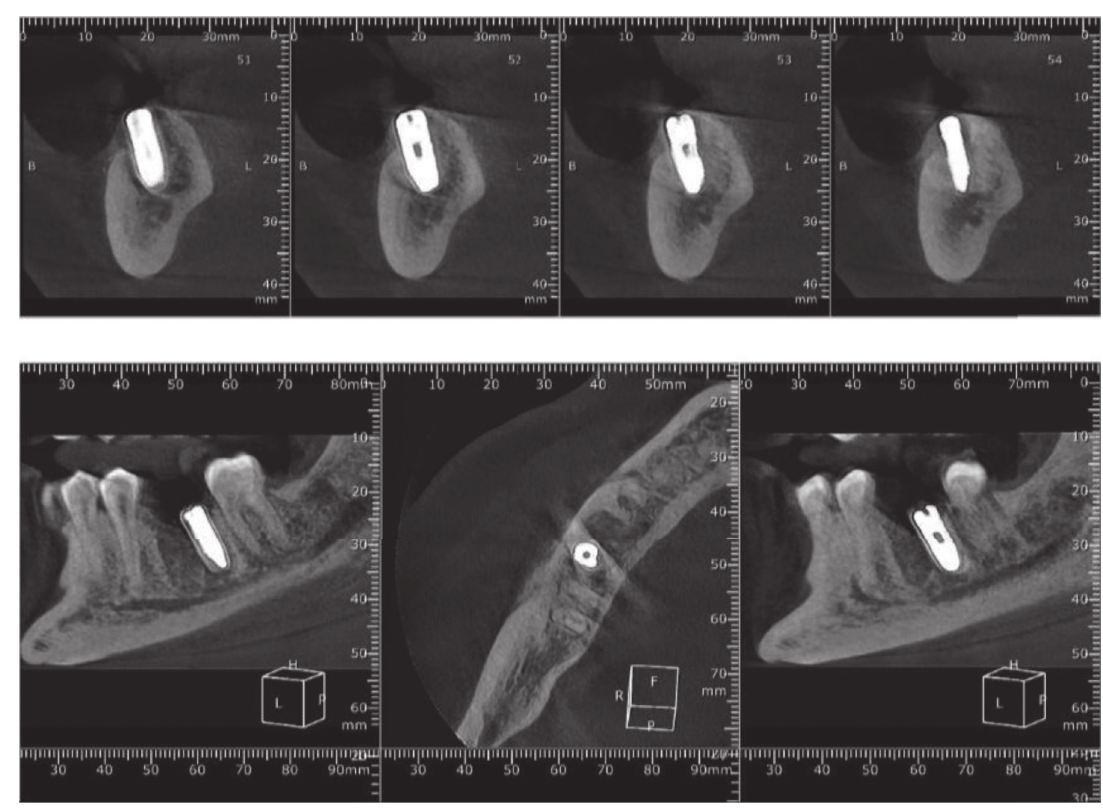
Figure 7: CBCT scanning postoperatively. Table 1: Radiographic measurement of the two studied groups in different observation